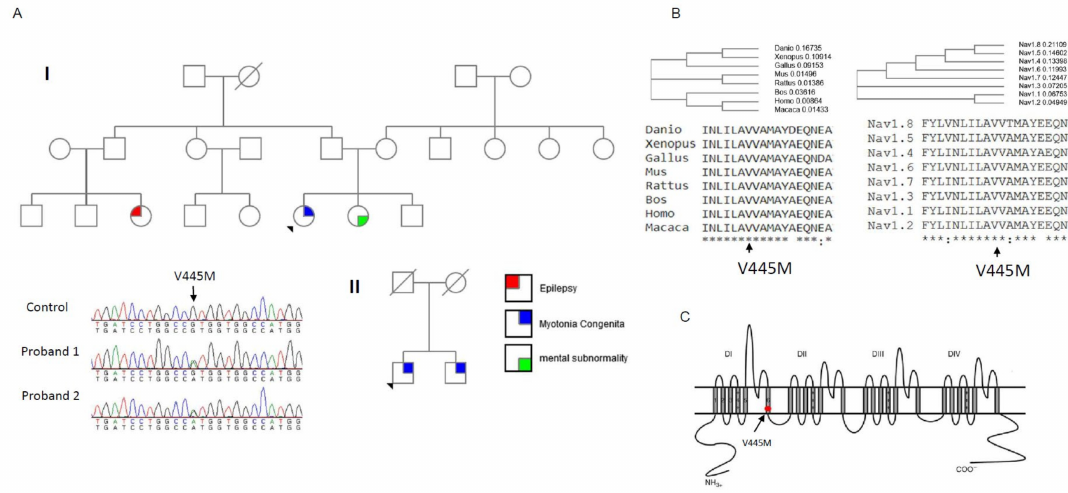
Figure 1. Sequence chromatography of the mutation and multiple sequence alignments for Na v 1.4 channels. ( A ) The pedigrees from two individual families (Family I and II) with the index cases are shown in the upper and lower panels, respectively. Both index cases su ff ered from muscle myotonia with muscle hypertrophy. In Family I, the sister of the index case su ff ered from mental subnormality and one of her relative had seizure history. Both the index case and his brother from Family II su ff ered from myotonic myopathy. The sequence chromatography (left side of lower panel) shows a variant, c.G1333A at exon 9 of the SCN4A gene, which causes a p.V445M mutation. Both probands have the sequence variant. The variant is not found in the relatives of the index case of Family I. In Family II, both the proband and his brother share the same sequence variant. ( B ) The amino acid V445 is highly conserved among species during evolution and in the protein family of voltage-gated sodium channels. ( C ) The topology of the Na v 1.4 channel shows that the mutation is located at the sixth transmembrane segment of Domain I (DI /